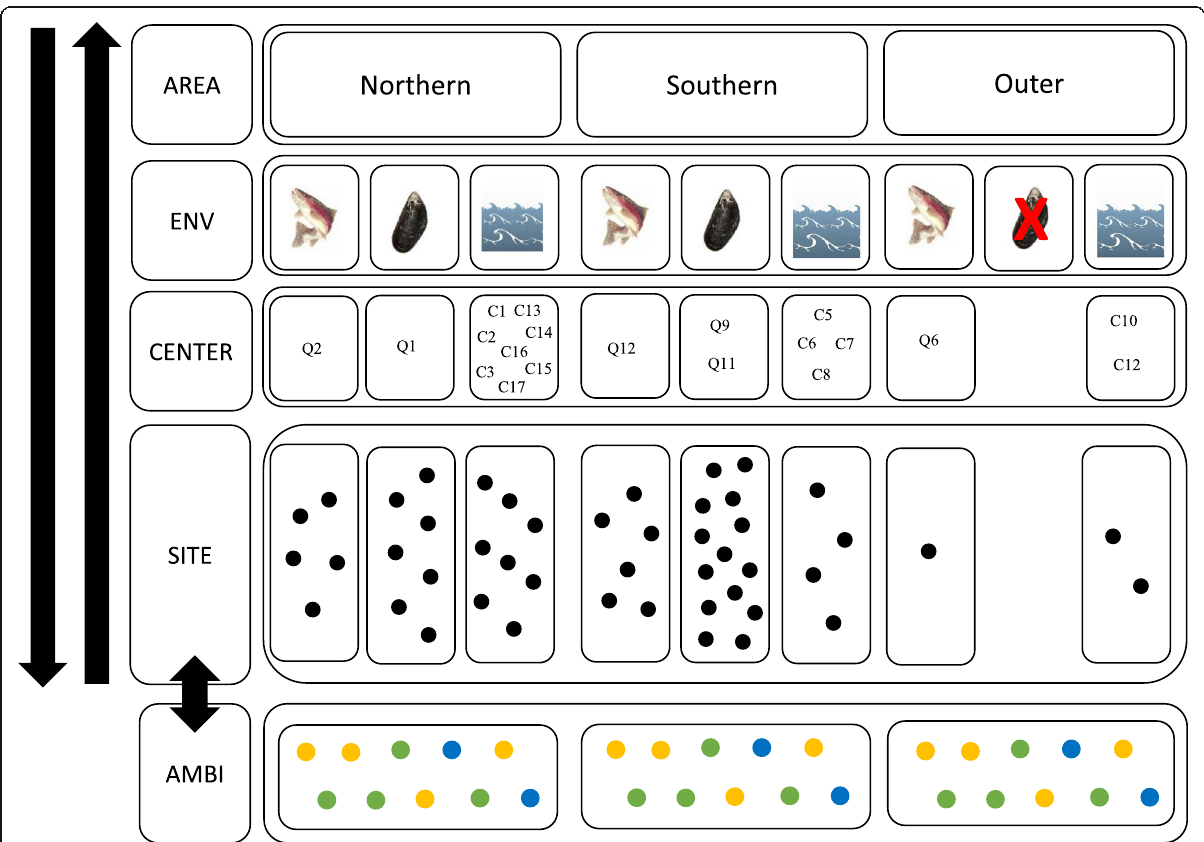
Fig. 9 Conceptual model for community dissimilarity of benthic macrofauna and for the ecological status of Caucahue Channel at different spatial scales of observation (i.e. factor of analysis). From top to bottom the factors are: AREA (northern, southern and outer), ENV (salmon, mussel and references), CENTER (Q i to C i ) and SITE (each sampling site, represented with a black circle). From the PERMANOVA analysis significant differences were observed for each of these 4 factors between their different levels of comparison, which are indicated by areas with segmented lines. The ascending and descending black arrows represent hierarchy links present from the entire study AREA to the sampling sites (SITE) and vice versa. The black arrows pointing in two ways represent the relationship between the sampling sites and each of the replicates used for the estimations of ecological status using AMBI. The color circles represent a spatially explicit environmental traffic light to the smallest spatial scale possible (i.e., each replicate). For each of the factors studied in the Caucahue Channel (AREA, ENV and CENTER) it is possible to identify replicates (i.e. sampling SITES) ranging from undisturbed (blue circles) to moderately disturbed (yellow circles). For further details see the Discussion